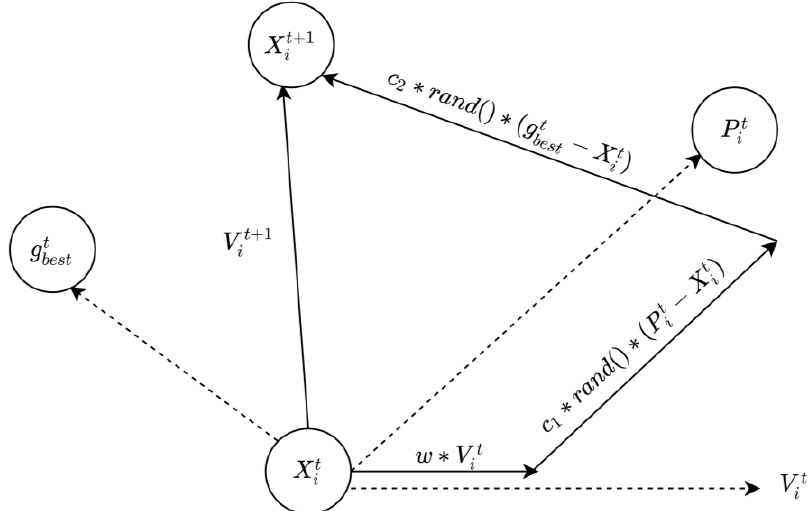
Figure 1. An iterative particle movement in PSO.